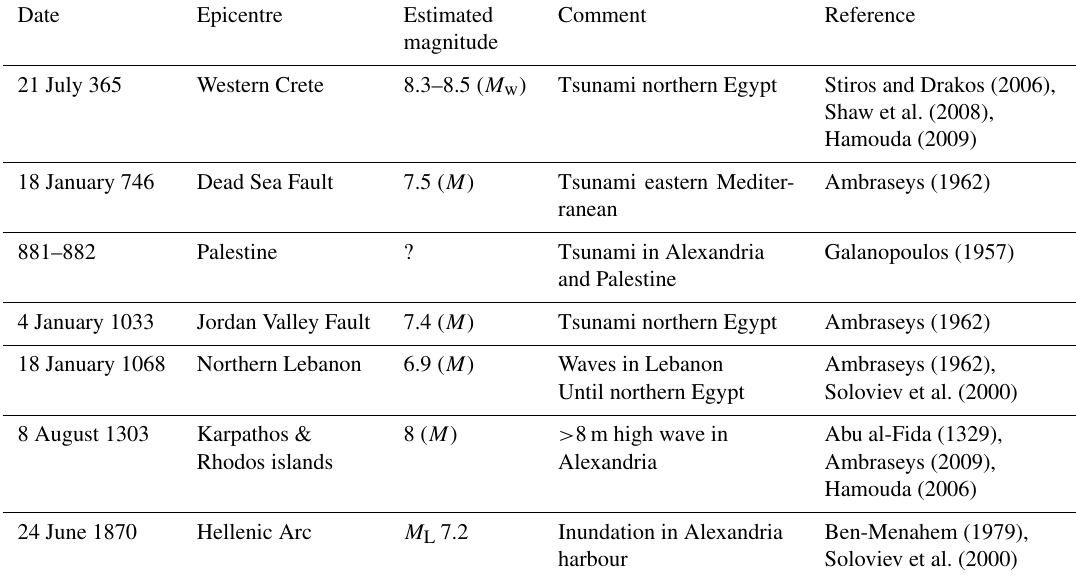
Table 1. Major earthquakes of the eastern Mediterranean with tsunami wave records in northern Egypt. Estimated magnitudes are given in M w when calculated and in M when